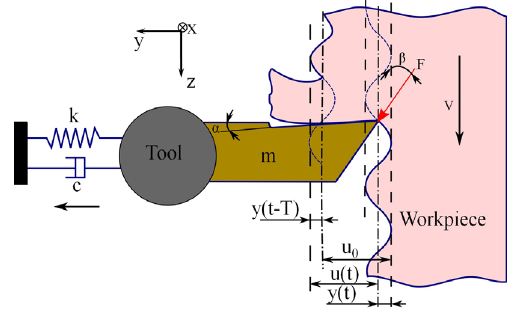
Figure 1. A single degree model representing boring operation. [35]